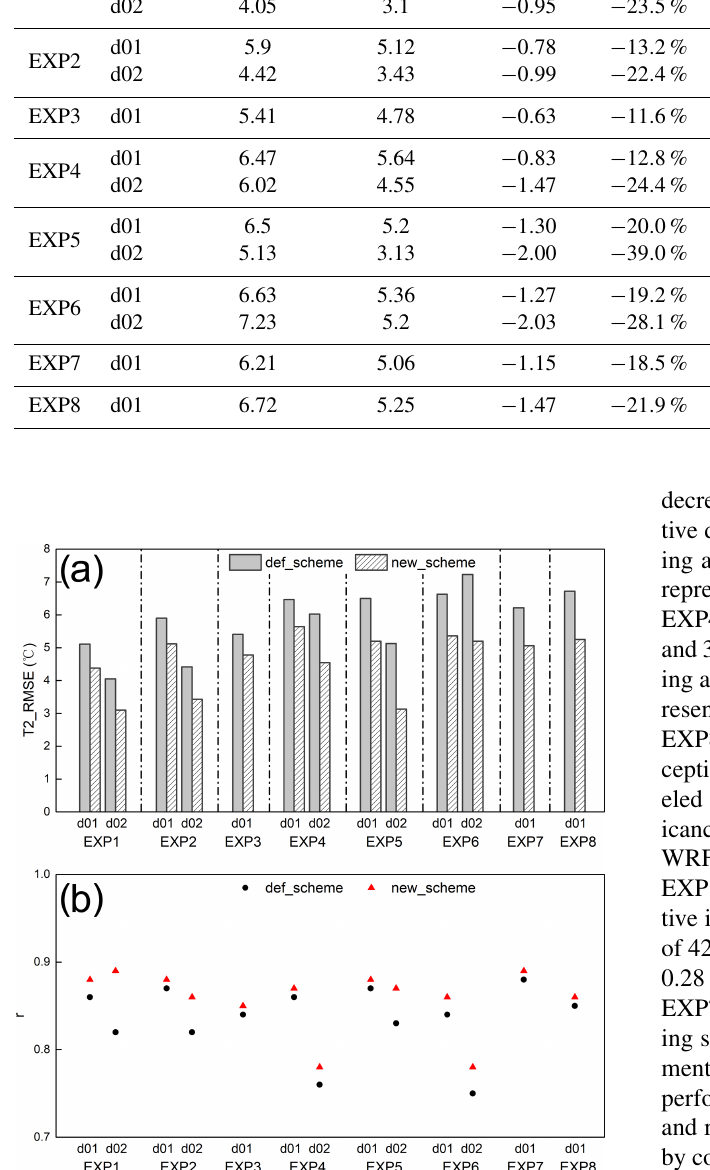
Figure 3. RMSE (a) and correlation coefficient (b) for air temper- ature (T2) between observations and model estimates in d01 and d02. The correlation coefficient is significant at the 0.01 significance level. For def_scheme and new_scheme, see Fig.